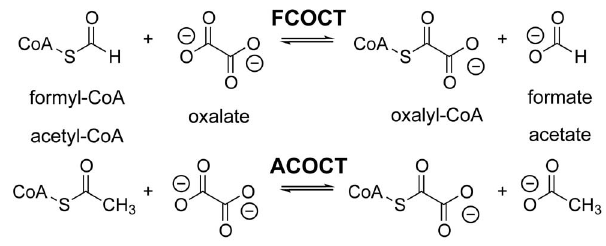
Figure 1. Class III CoA-transferase reactions. FCOCT and ACOCT reactions.